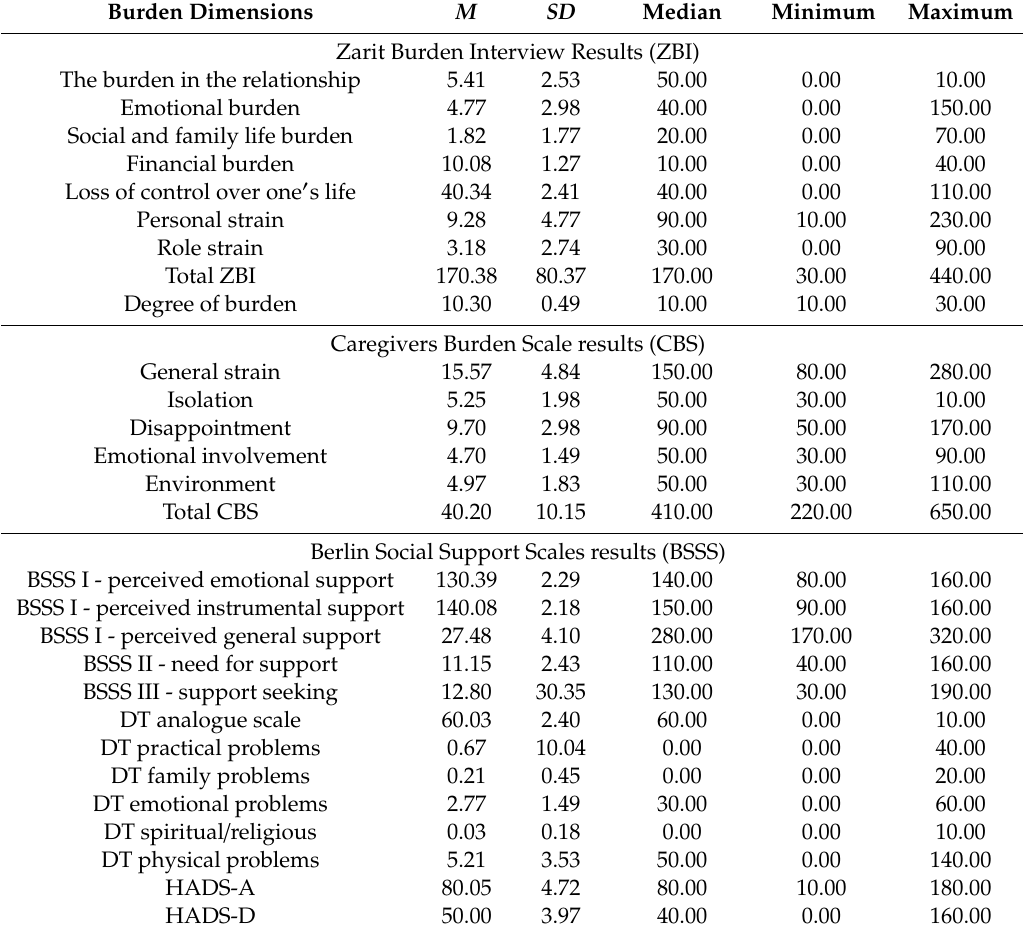
Table 2. Results of the ZBI, CBS, and the BSSS in the male partners of the women with cancer. Burden Dimensions M SD Median Minimum Maximum Zarit Burden Interview Results (ZBI) The burden in the